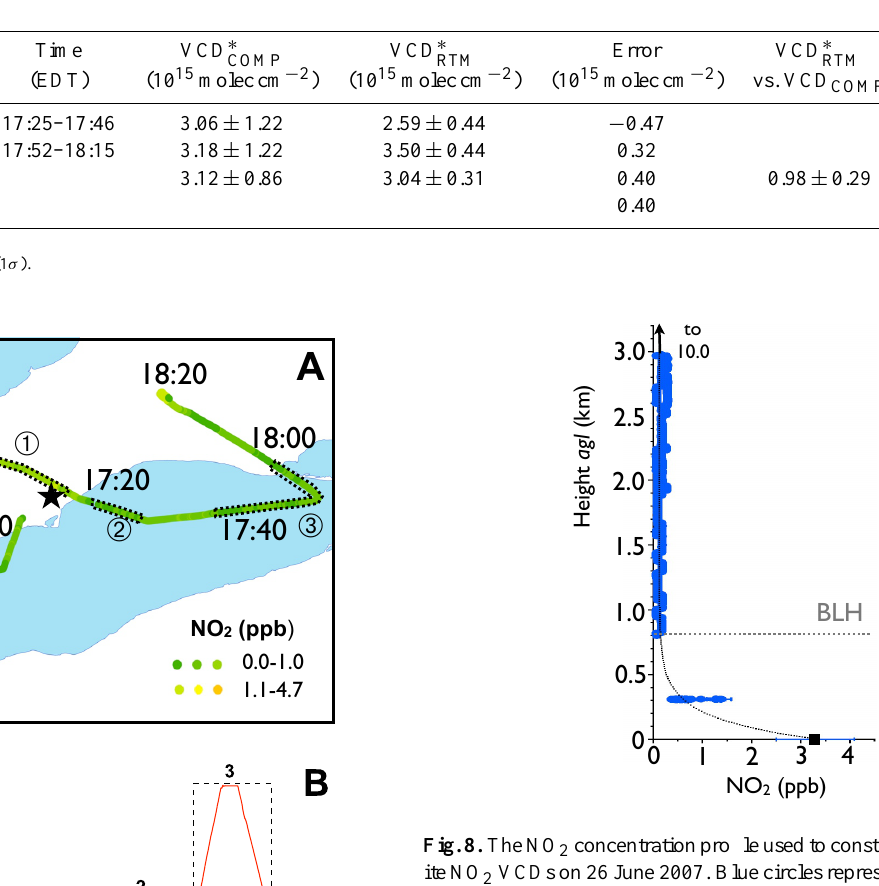
Table 1. Comparison of RTM and composite VCDs of NO 2 on 26 June 2007.